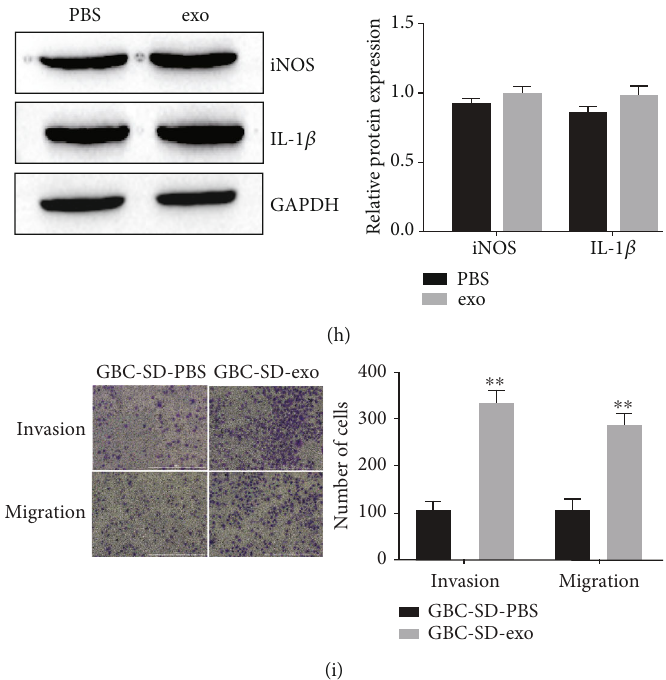
Figure 1: GBC-SD cell-derived exosomes promote M2 macrophage polarization and subsequently enhances cell invasion and migration. (a) Identi fi cation of GBC-SD cell derived exosome by electron microscopy. (b) Exosome protein expression was detected by Western blot. (c) Identi fi cation of macrophage by fl ow cytometry. (d) qRT-PCR to detect the speci fi c markers for M2-subtype macrophages. (e) Western blot to detect the speci fi c markers for M2-subtype macrophages. (f) Flow cytometry determining the percentage of CD163 + CD206 + cells among total CD68 + cells after induction. (g) qRT-PCR to detect the speci fi c markers for M1-subtype macrophages. (h) qRT-PCR to detect the speci fi c markers for M1-subtype macrophages. (i) Transwell assay to detect invasion and migration of GBC-SD cell with PBS or GBC-SD cell derived-exosome treated. Invasion and migration of GBC-SD cell were quanti fi ed. Data in (b – i) are representative of three independent experiments; the P value was determined by Student ’ s t